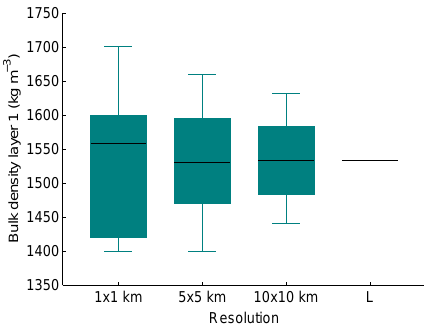
Figure 11. Distribution of bulk density over the grid cells for the four different spatial